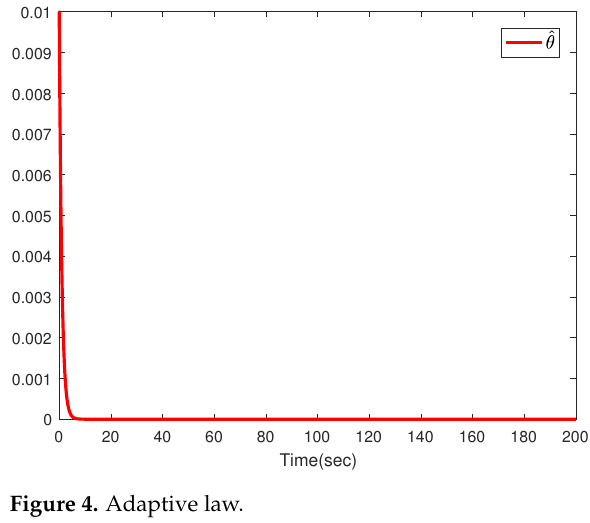
Figure 4. Adaptive law.